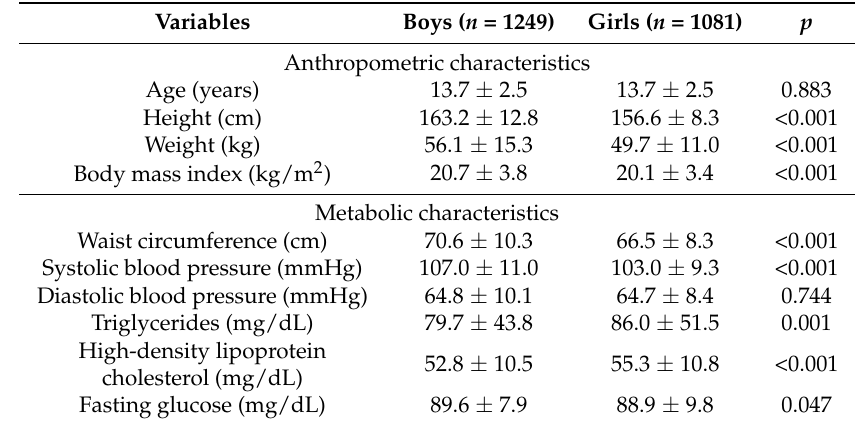
Table 2. Anthropometric and metabolic characteristics of the subjects by sex.